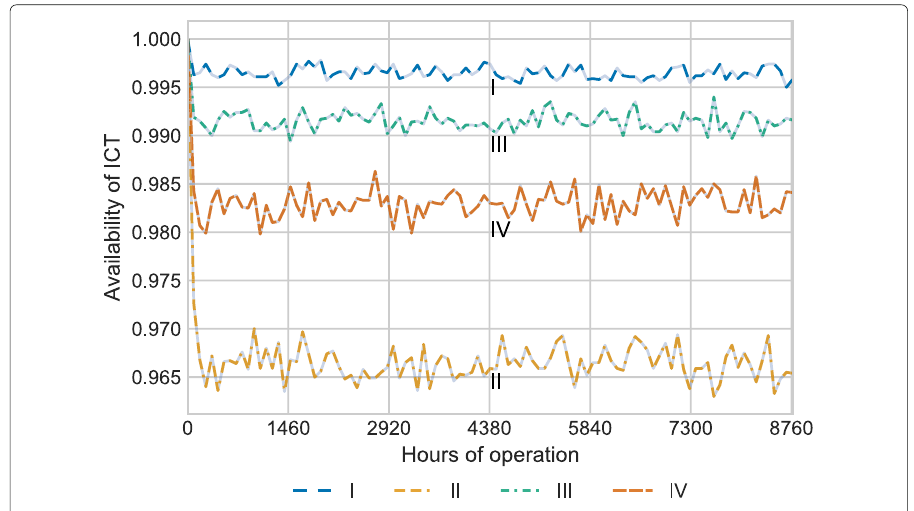
Fig. 8 Availability of the ICT services needed for